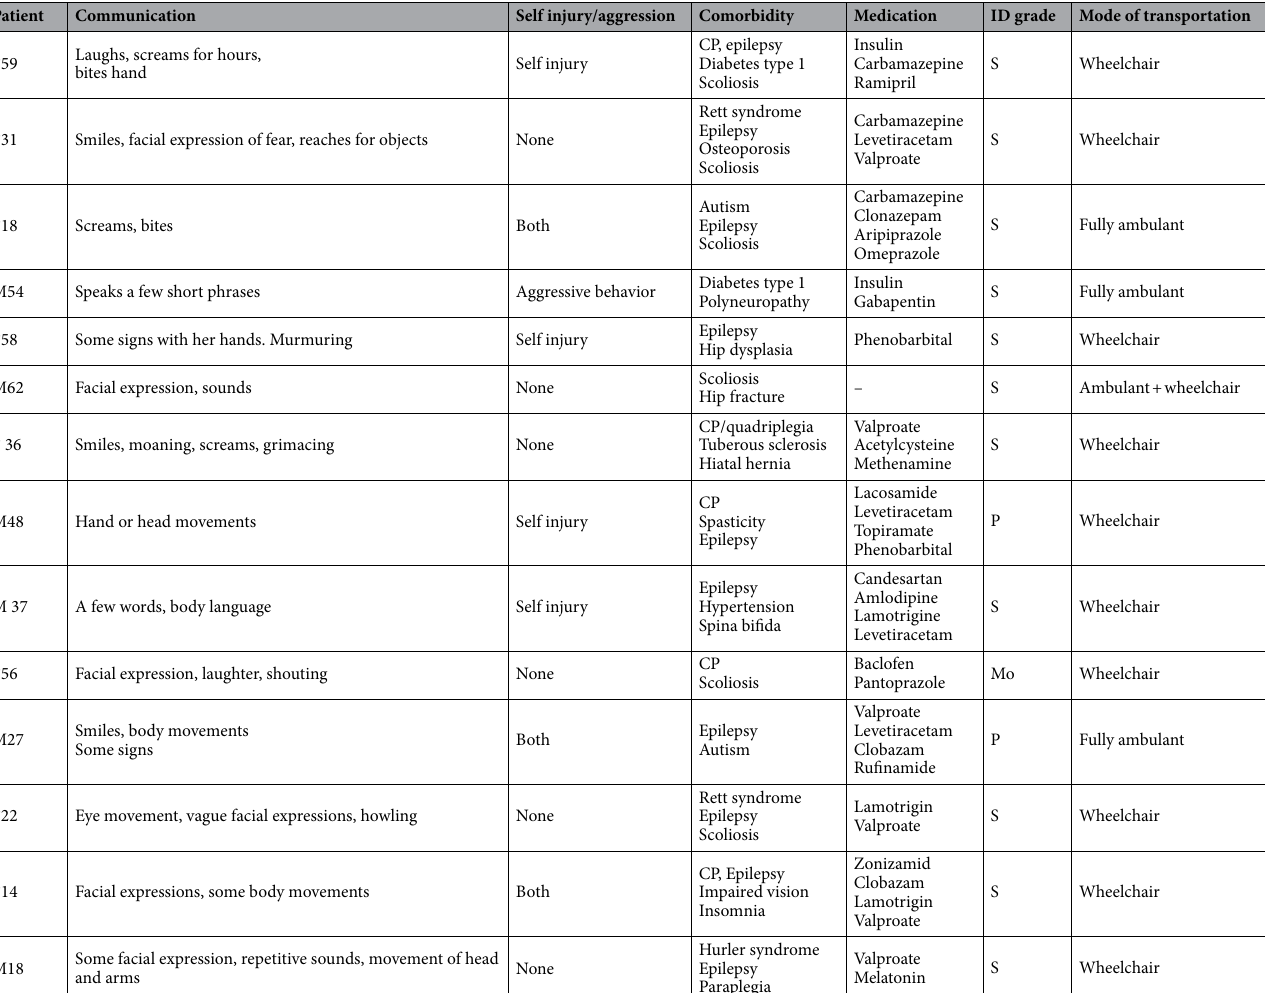
Table 1. Clinical characteristics of patients. Sex and age (first column), modes of expession, presence of aggressive or self-injurious behavior, comorbidities, medication, degree of intellectual disability, and mode of transportation in 14 non-communicating persons with ID. Abbreviations: CP: cerebral palsy, F: female, ID: intellectual disability, M: male, Mo: moderate ID (IQ 35–49), S: severe ID (IQ 20–34). P: profound ID (IQ <